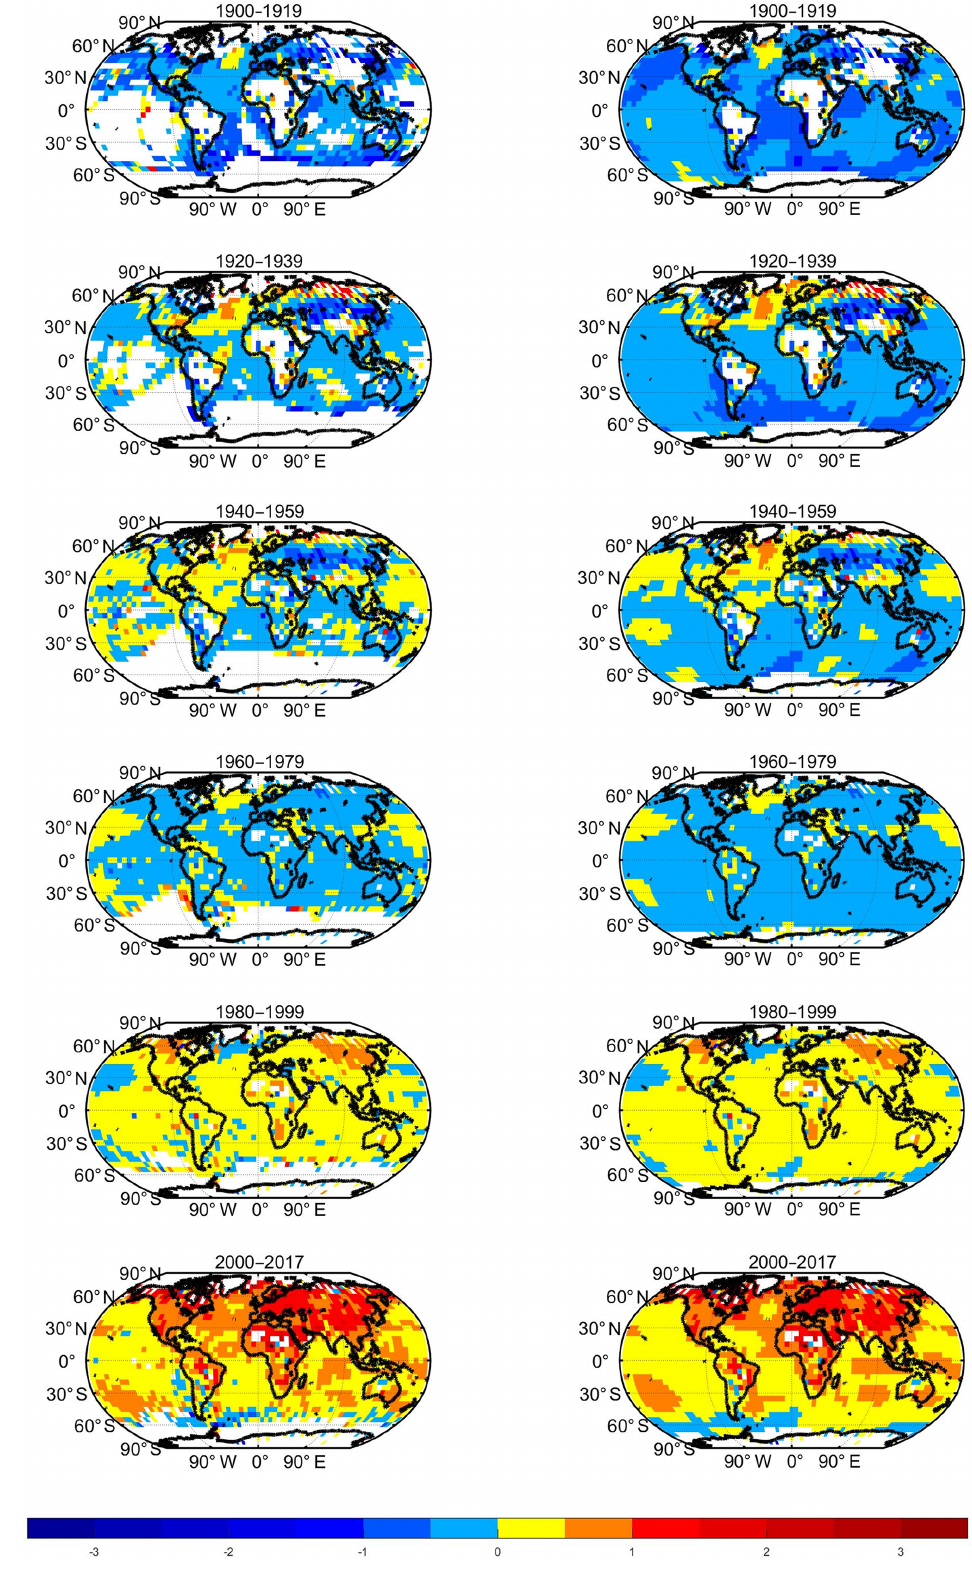
Figure 4. Spatial distribution of 20-year average temperature anomalies between 1900 and 2017 in Merge1 (left) and Merge2 (right).